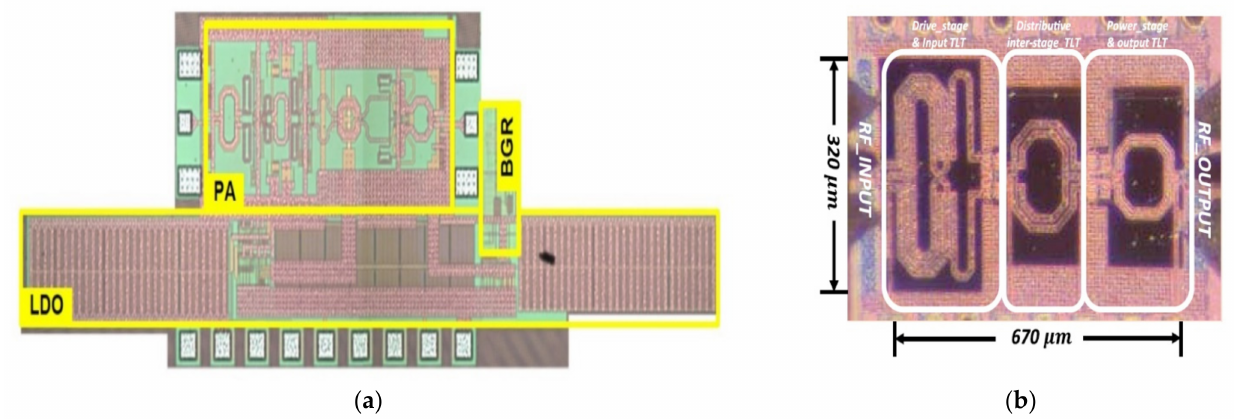
Figure 9. ( a ) The 3-stage CS cascode PA in 65 nm CMOS and LDO [49], ( b ) 2-stage differential cascode PA in 40 nm CMOS